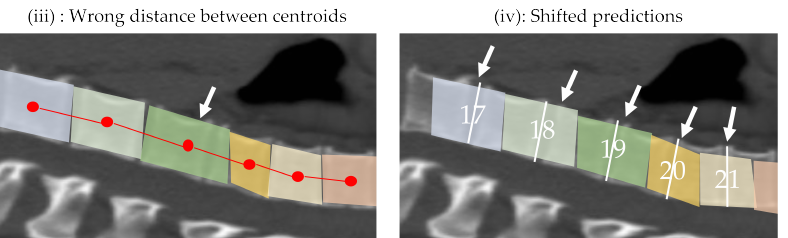
Figure 3. Visual representation of the sanity checks performed by the proposed Domain Sanity Loss (DSL) function; the displayed cases show failures for each check, indicated by the white arrows. Specifically, the DSL loss checks for ( i ) monotonous ascend of predicted vertebrae numbers along the spine; ( ii ) all spine pixels in one column of the image having the same vertebra number; ( iii ) predicted vertebrae centroids having a reasonable distance to each other, based on average distances from the literature; and ( iv ) predictions not being shifted along the spine, based on an unsupervised weak segmentation of the vertebrae (c.f. Figure